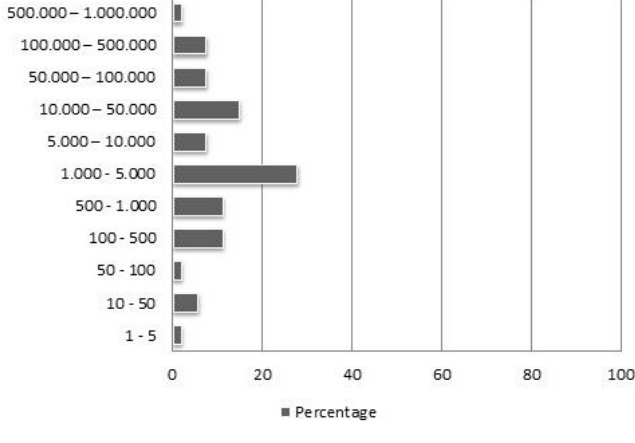
Figure 3. Frequency distribution of number of downloaded (for apps from the Google Play store). Data is presented as percentage of total number of apps